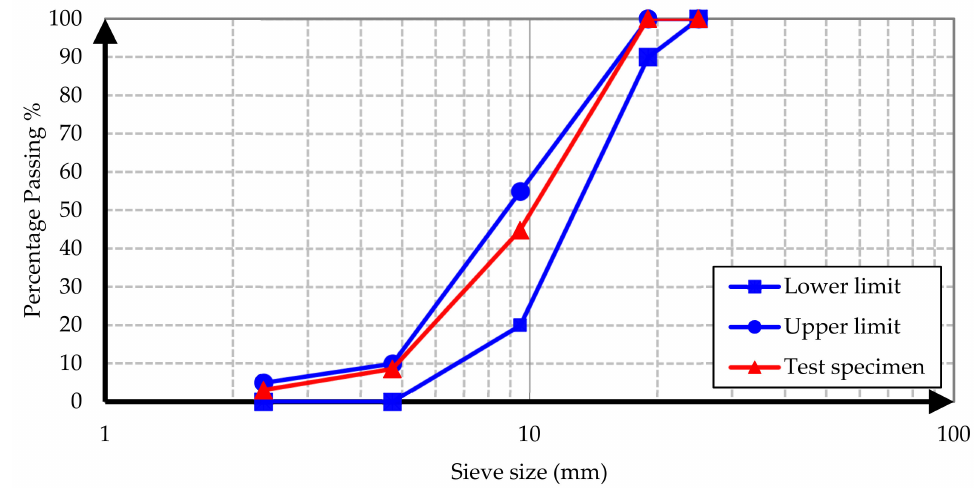
Figure 3. Barite gravel sieve analysis grading curve.